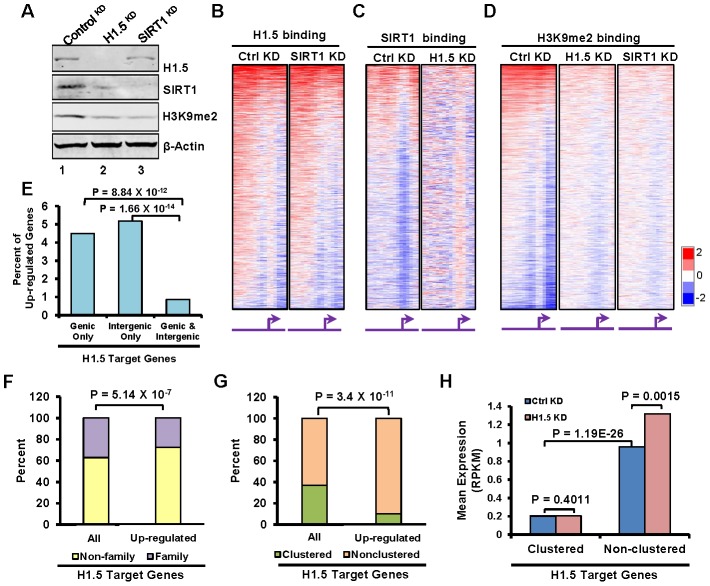
H1.5 is required for enrichment of SIRT1 and H3K9me2 at H1.5 target loci and normal gene expression pattern.(A) Western blotting of H1.5, SIRT1, H3K9me2, and β-Actin in controlKD, H1.5KD, and SIRT1KD IMR90 cells. (B–D) Genome wide promoter binding of the indicated factors and experimental conditions is shown as heat maps. The genes are ordered as in Figure 2A. (E) Percentage of up-regulated genes with the indicated H1.5 binding pattern. The binomial p-values are indicated. (F) Stacked bar chart of percentage of family (yellow) and non-family (purple) genes in all H1.5 targets (left bar) and up-regulated H1.5 targets (right bar). The binomial p-value is indicated. (G) Stacked bar chart of percentage of clustered (orange) and non-clustered (burlywood) in all H1.5 targets (left bar) and up-regulated H1.5 targets (right bar). The binomial p-value is indicated. (H) Expression levels (mRNA-seq) of clustered and non-clustered H1.5 target genes in controlKD and H1.5KD cells are shown as a bar chart.